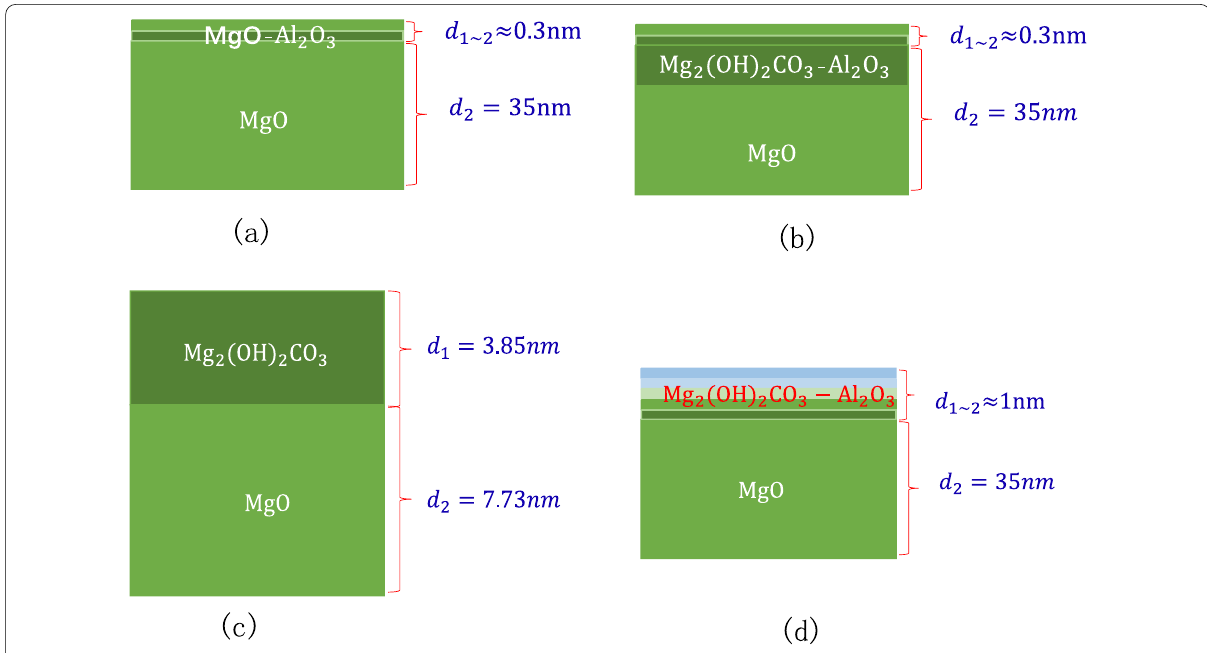
Fig.15 Schematic diagram of XPS test experiment sample, a shows the information of MgO/Al 2 O 3 (on the silicon wafer, grow 35 nm-MgO, and then grow 0.3 nm-Al 2 O 3 ), b shows the information of deliquescent MgO/Al 2 O 3 (on the silicon wafer, grow 35 nm-MgO, and then grow 0.3 nm-Al 2 O 3 ), c shows the information of deliquescent MgO (on the silicon wafer, grow 11 nm-MgO), d shows the information of deliquescent MgO/Al 2 O 3 (on the silicon wafer, grow 35 nm-MgO, and then grow 1 nm-Al 2 O 3